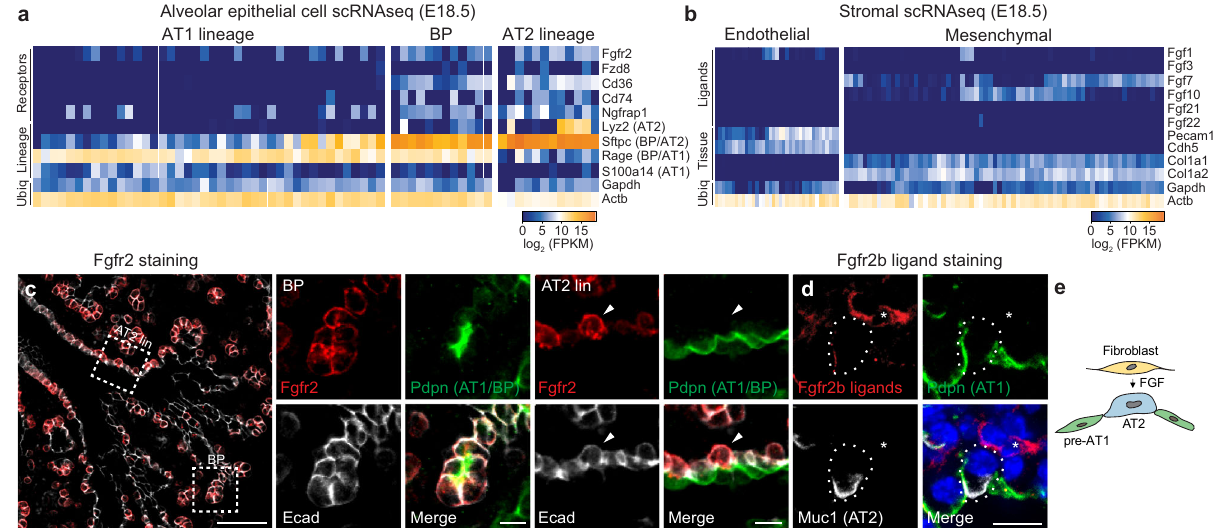
Fig. 1 | Expression of Fgfr2 and its ligands during alveolar differentiation. a Expressionof Fgfr2 and thefourotherreceptorgenesmostselectivelyexpressed in alveolar type 2 (AT2) cell lineage ( “ Receptors ” ) from single-cell RNA sequencing (scRNAseq) analysis of distal (alveolar) epithelial cells from embryonic day 18.5 (e18.5) mouse lung. Cells (columns) are arranged in developmental pseudotime (BP, bipotent progenitors, center; AT1 lineage to the left; AT2 lineage to the right) determinedasdescribedinref.11byexpressionofalveolarlineagemarkerslikethe four shown( “ Lineage ” )including twothatrestrictfrom BP to AT2lineage(BP/AT2, Sftpc ) or to AT1 lineage (BP/AT1, Rage ). (Note due to the very high expression of Sftpc in bipotent progenitors, there is a temporal lag in the extinction of the tran- scripts in newly-differentiating AT1 cells and thus some nascent AT1 cells co- express Sftpc and Rage .) Ubiq, ubiquitously-expressed control genes. Heat map, mRNA expression level. b Expression of Fgfr2b ligand genes in distal (alveolar) endothelium and mesenchyme from scRNAseq of e18.5 lung. c e17.5 lung immu- nostained for Fgfr2 (red), bipotent progenitor (BP) and AT1 marker podoplanin (Pdpn, green), and epithelial marker E-cadherin (E-cad, white). Boxed regions,